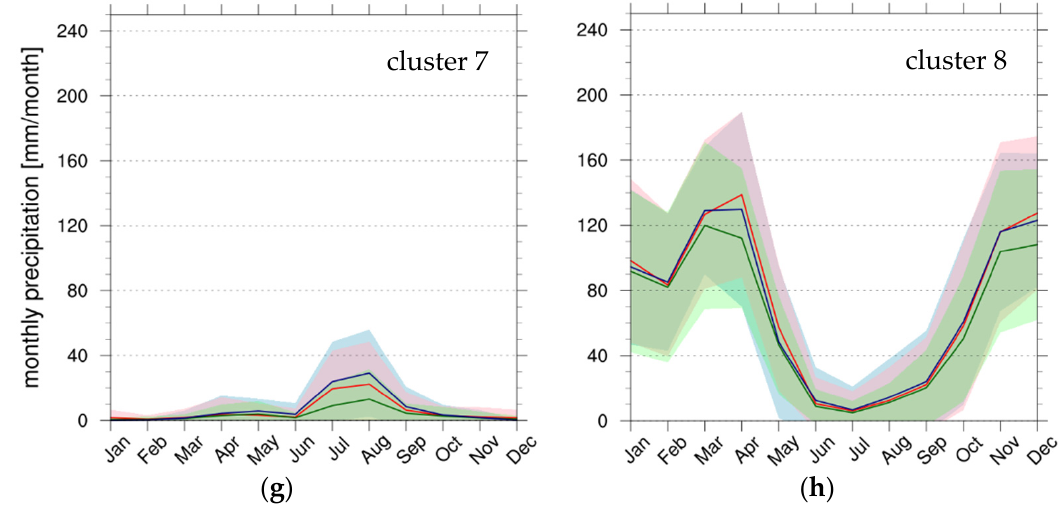
Figure 6. Mean precipitation annual cycles for each EA cluster, from cluster 1 ( a ) to cluster 8 ( h ) , and precipitation product: MSWEP (green), CHIRPS (red), and TAMSAT3 (blue). The shaded areas identify the standard deviation ( ± σ ) for each precipitation product, MSWEP (light green), CHIRPS (pink) and TAMSAT3 (light blue).